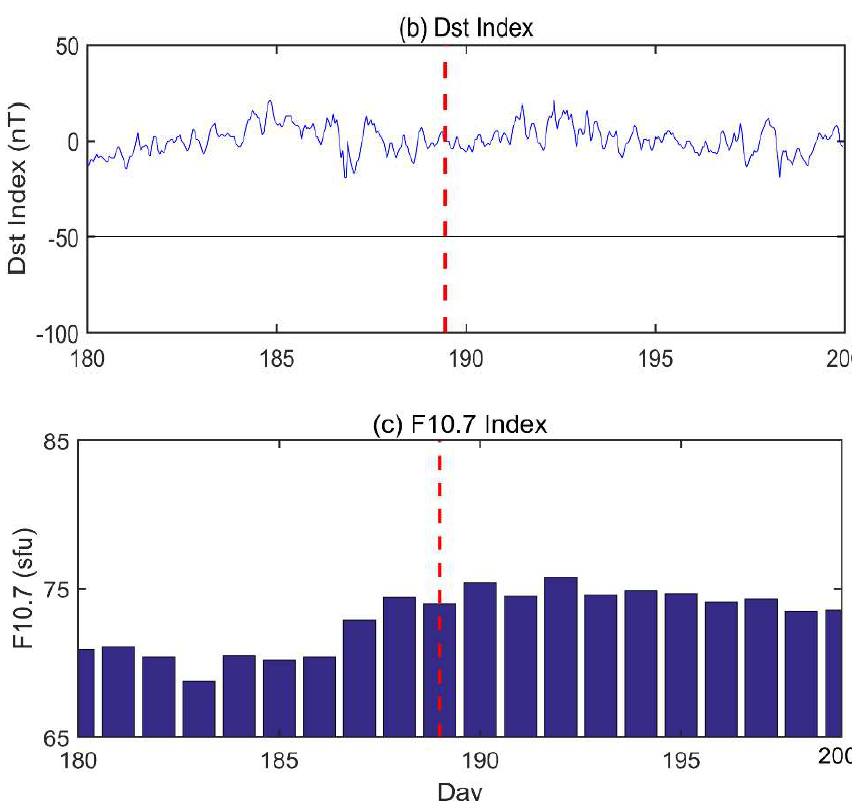
Figure 11. The ( a ) Kp index, ( b ) Dst index and ( c ) F10.7 index from June 29 to July 18 (DOY 180-200), Figure 11. The Kp index ( a ), Dst index ( b ) and F10.7 index ( c ) from June 29 to July 18 (DOY 180-200), 2018.